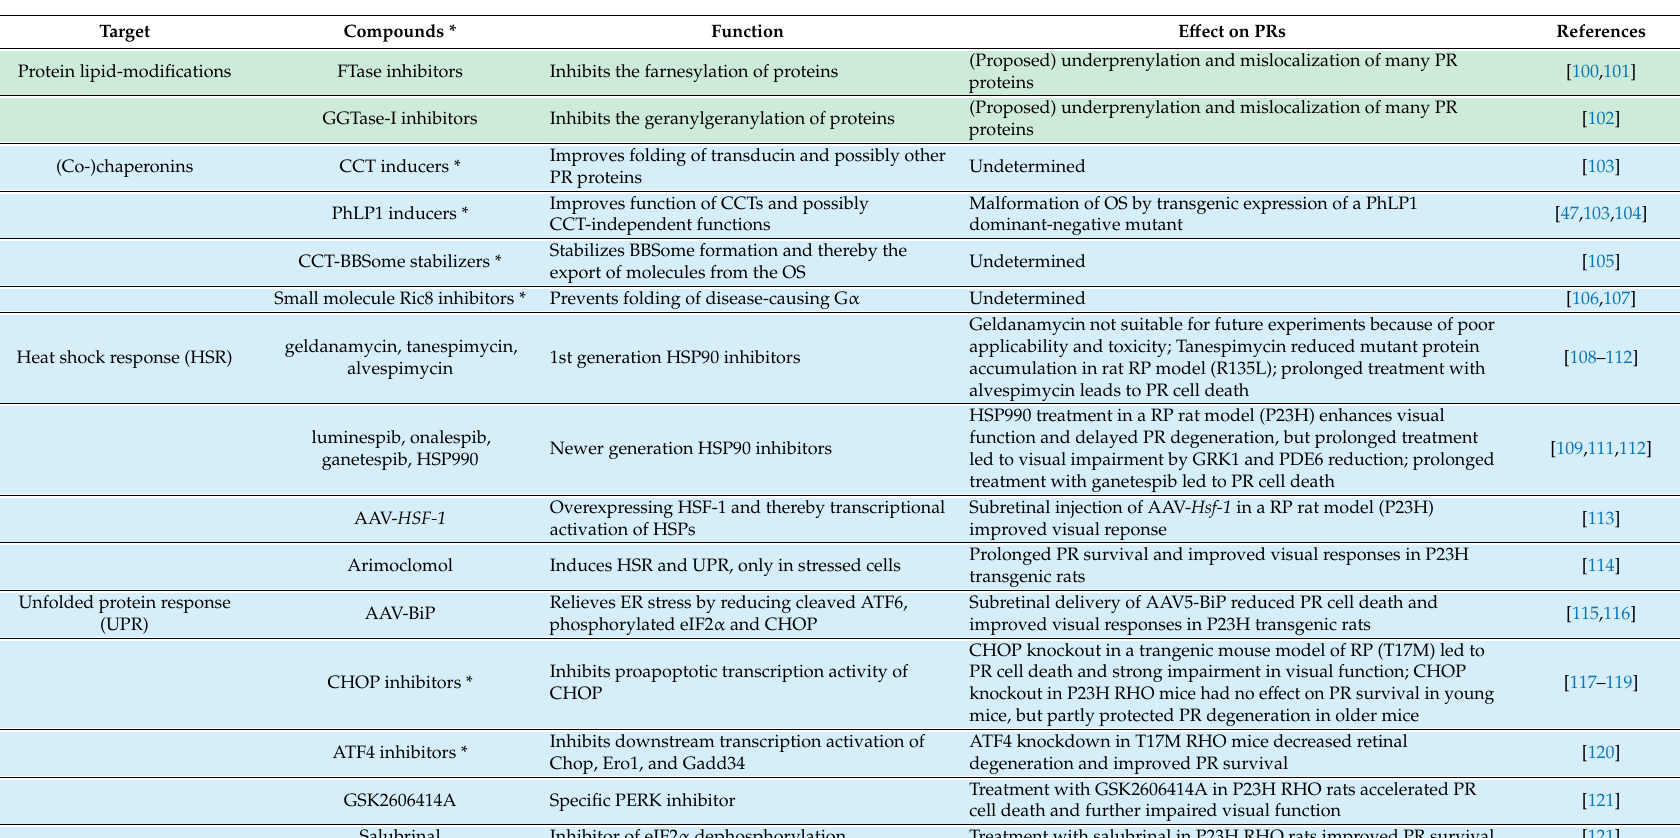
Table 1. Therapeutic compounds directed against the di ff erent branches of the proteostasis network (PN). Therapeutic compounds are divided based on which branch of the PN they target, including tra ffi cking (green), folding (blue), and degradation (red). Subgroups include compounds directed against protein lipid-modifications, (co-)chaperonins, HSR, UPR, ERAD, and autophagy. * Compounds that are not yet